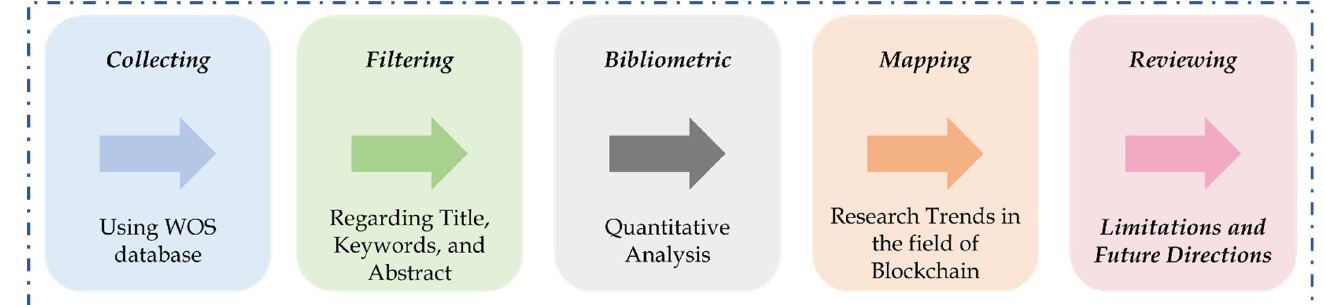
Figure 2. The research’s methodology and framework.